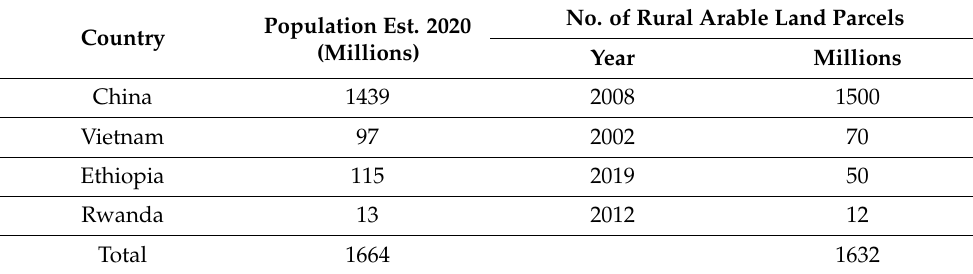
Table 1. Population and rural land parcels of case study countries.